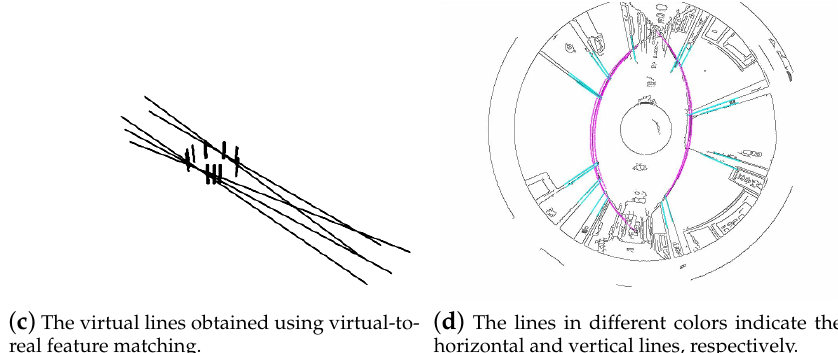
Figure 7. The line matching between the virtual room and the real